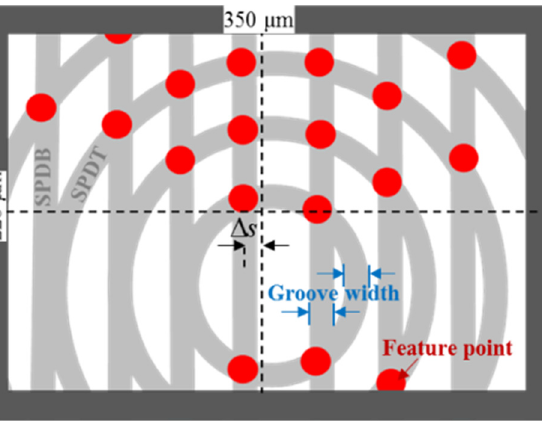
Figure 3. Geometrical relationship between feature point distribution in a microscope’s field of view.